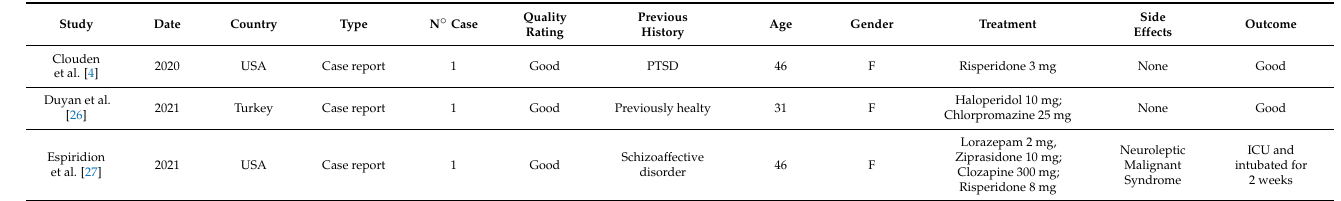
Table 1. Characteristics of the case report and case series included in the systematic review.